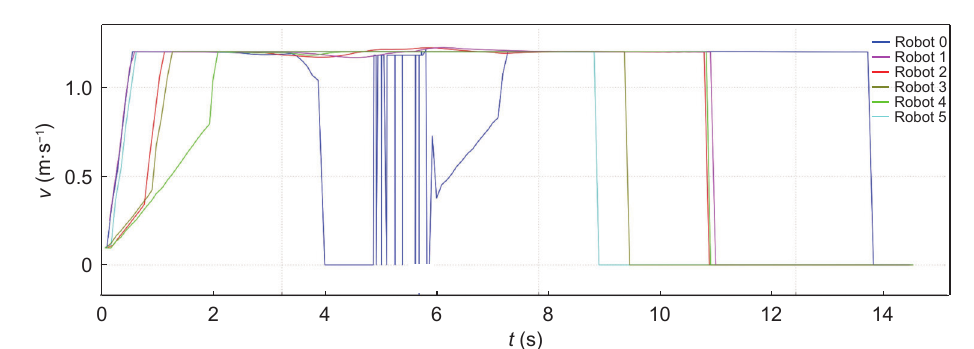
Fig. 17 Velocity evolution by using the D-MPC method.